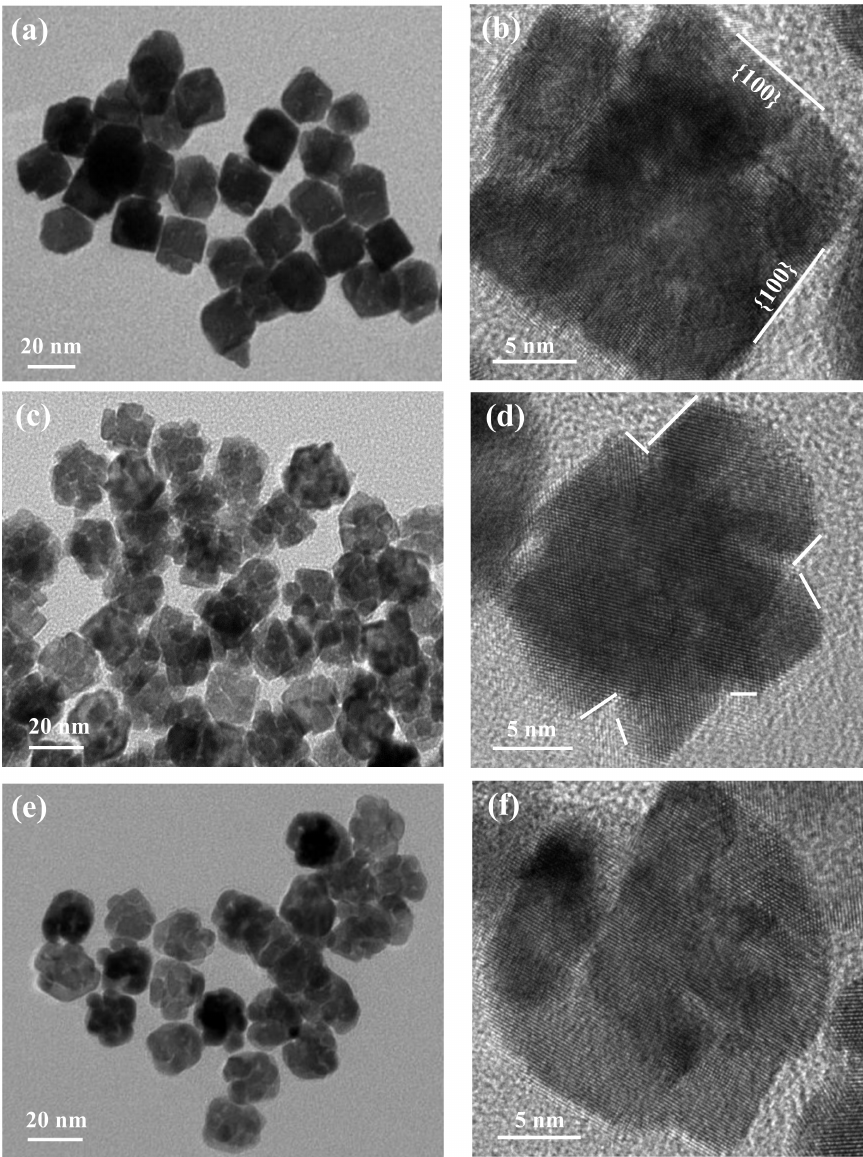
Figure 3. Morphologies of Pt–Pd nanostructures prepared at different temperatures. TEM